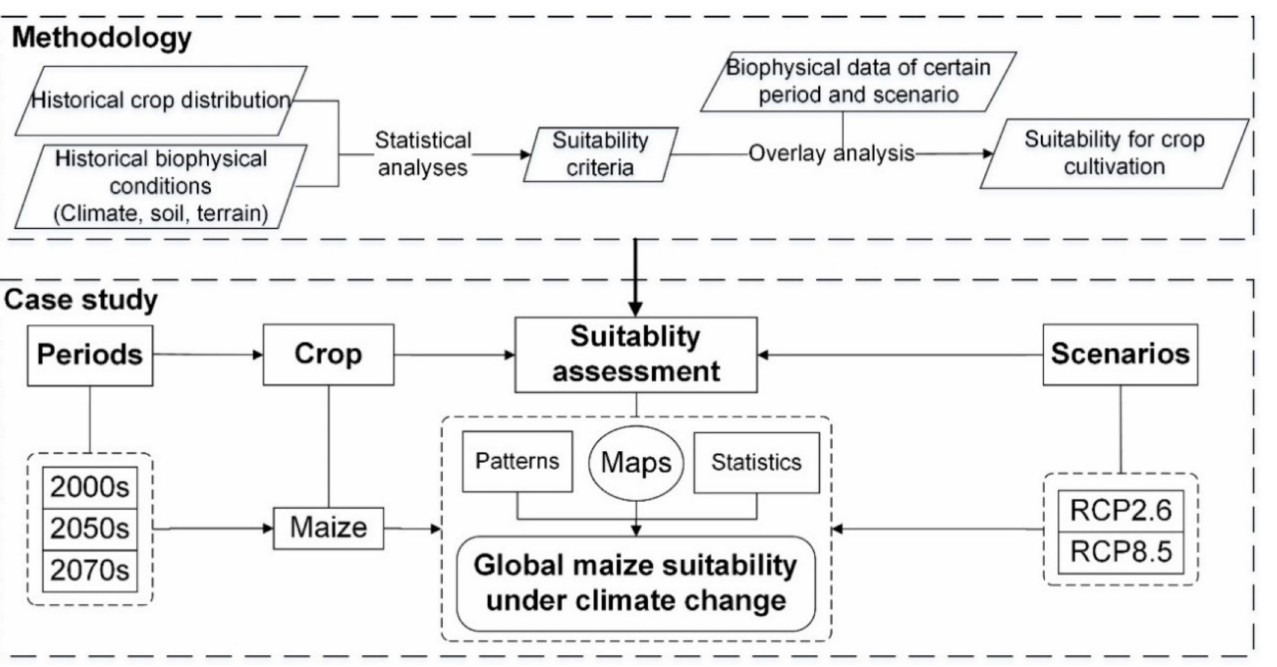
Figure 1. Research